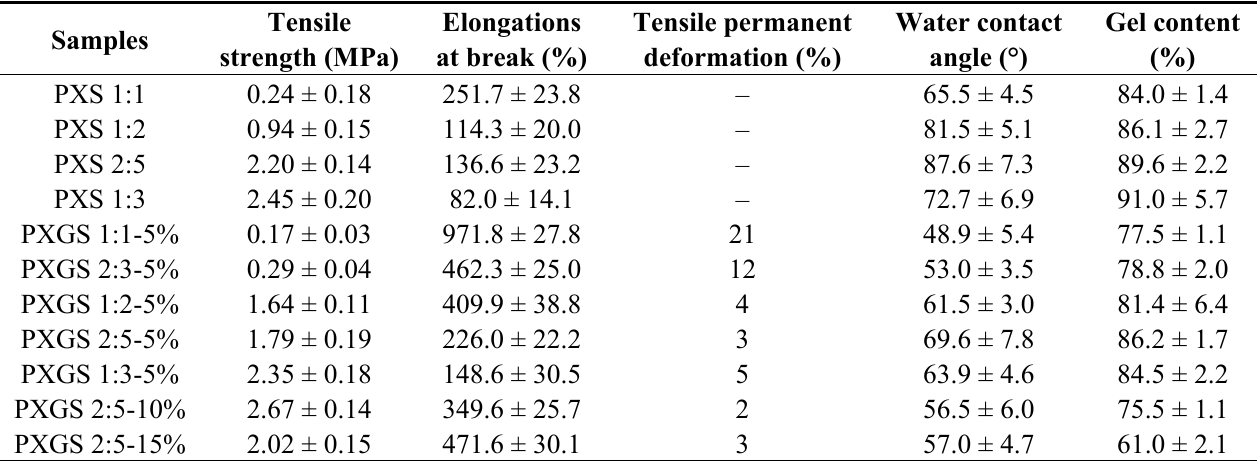
Table 2. Mechanical properties, water contact angle and gel content of different monomer ratios of PXGS and poly(xylitol sebacate) (PXS).